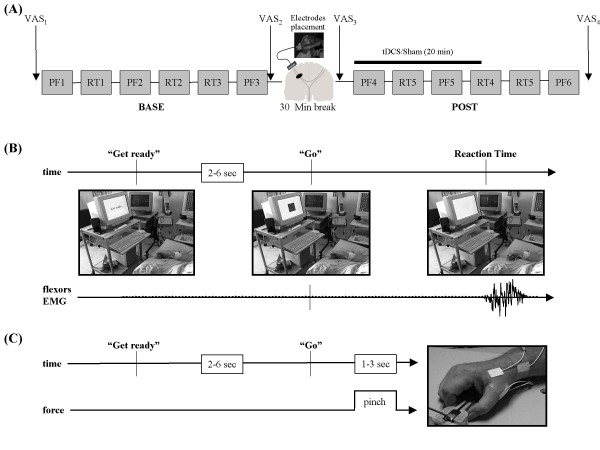
(A) Experimental design of a single session. In this study we used a double-blind, crossover study design with 2 sessions (tDCS and Sham). Half of the patients started with tDCS and the other half with Sham. Each session started with baseline determinations (BASE) of reaction times (RT1–3) and pinch force (PF1–3), followed by a 30 min break in which tDCS electrodes were placed. Then tDCS or Sham was applied in a counterbalanced double-blind design followed by post intervention measures (RT4–6 and PF4–6). All patients described their level of attention toward the task (range: 1–10; 1 = no attention, 10 = highest level of attention) and their perception of fatigue (range: 1–10; 1 = highest level of fatigue, 10 = no fatigue) four times in each session (VAS1-VAS4), and their sense of discomfort/pain after each session ended (range: 1–10; 1 = no discomfort/pain, 10 = maximal discomfort/pain) using visual analog scales (VAS) that have good internal consistency, reliability, and objectivity [24, 25, 27, 28]. Instructions to the patients were identical for all Sessions. In 4 patients an additional session was performed as a control experiment to evaluate the effects of No Stimulation compared to Sham stimulation. (B) Reaction Time Testing during a Visuo-Motor Task Patients were seated in a comfortable armchair and were instructed to focus attention on a cross in the centre of a video screen, and to bend their wrist as quickly as possible in response to a GO-signal presented on the screen. Trials were started with a visual warning signal ('Get ready'), followed by a GO-signal at random intervals (2–6 seconds). Blocks consisted of 23 wrist flexion trials with the first three trials of a block used as practice trials. These trials were not included in the analysis. EMG was recorded from silver-silver chloride electrodes positioned in a belly tendon montage on the skin overlying the Flexor Carpi Radialis muscle. Reaction times (RT) were defined as the time interval between the GO-signal and the onset of the EMG-burst in the Flexor Carpi Radialis muscle. Patients didn't receive any feedback about there performance. (C) Pinch Force Testing Task Patients were seated in a comfortable armchair with both arms relaxed. Maximal pinch strength of the paretic hand was measured according to a protocol with good validity and test-retest reliability [49, 50]. Patients held the arm of a dynamometer between the lateral aspect of the middle phalanx of the index finger and the thumb pad. Trials were started with a warning signal ('Get ready'), followed by a GO-signal at random intervals (2–6 seconds). Patients were instructed to squeeze the gauge as hard as they could for 1–3 seconds after GO-signal. Patients didn't receive any feedback about there performance. Blocks consisted of nine consecutive trials.